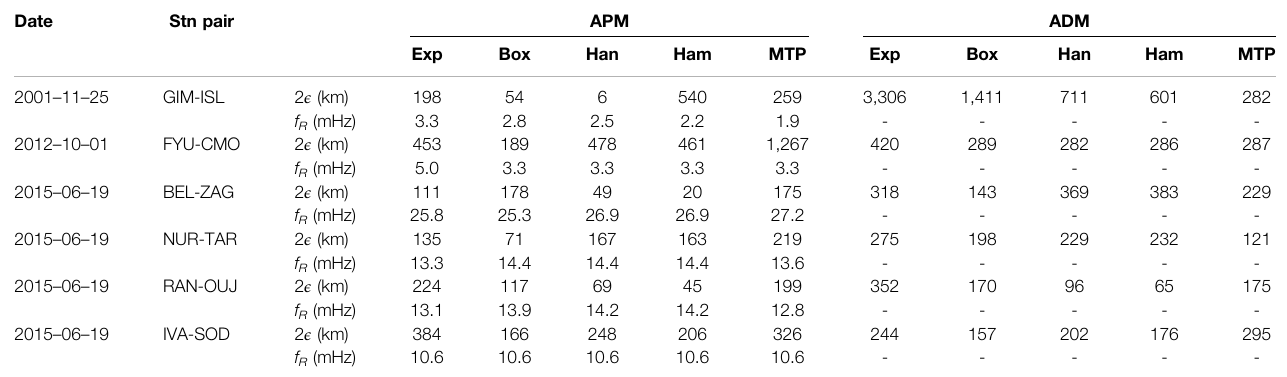
TABLE 3 | APM and ADM latitudinal resonance width (2 ε ) estimates (km) for all six FLR intervals.